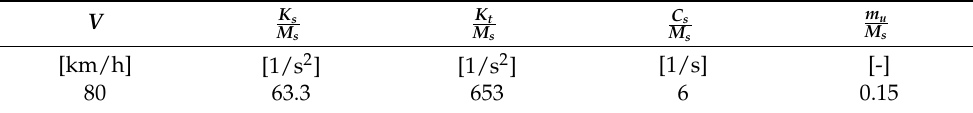
Table 3. QCM parameters.